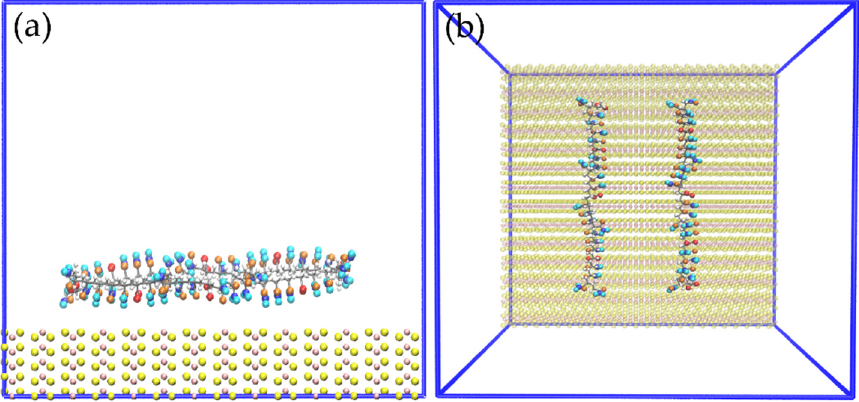
Figure 11. Snapshots of the initial configuration for simulation of two molecules of HPAM over the edge of MoS 2 : ( a ) side view, ( b ) top view.